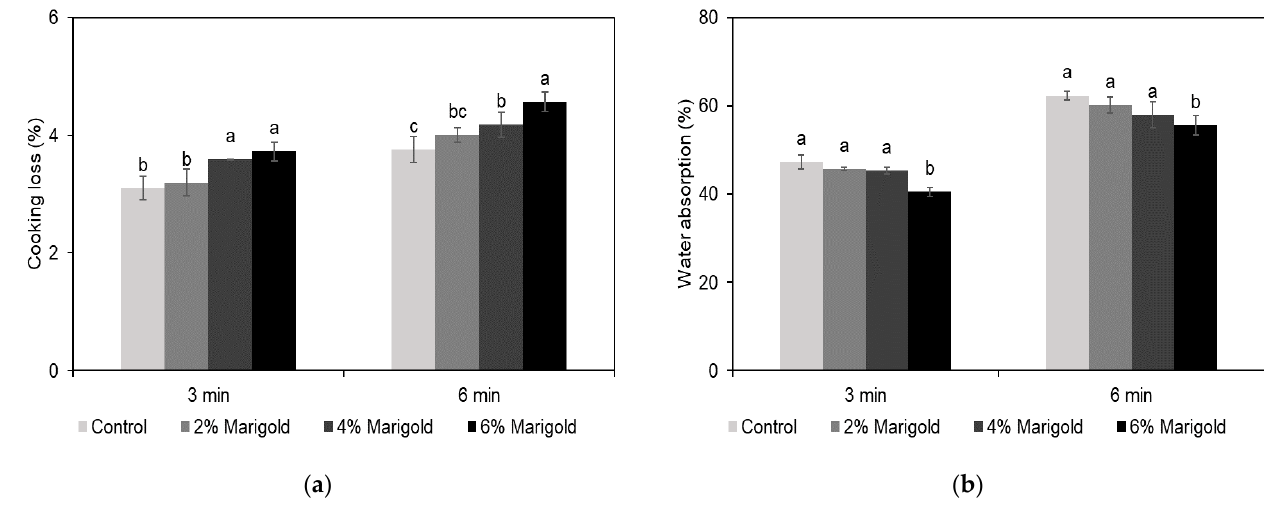
Figure 4. Effect of marigold powder on the cooking loss ( a ) and water absorption ( b ) of fresh noodles (means with different letters on the bars differ significantly at p < 0.05).